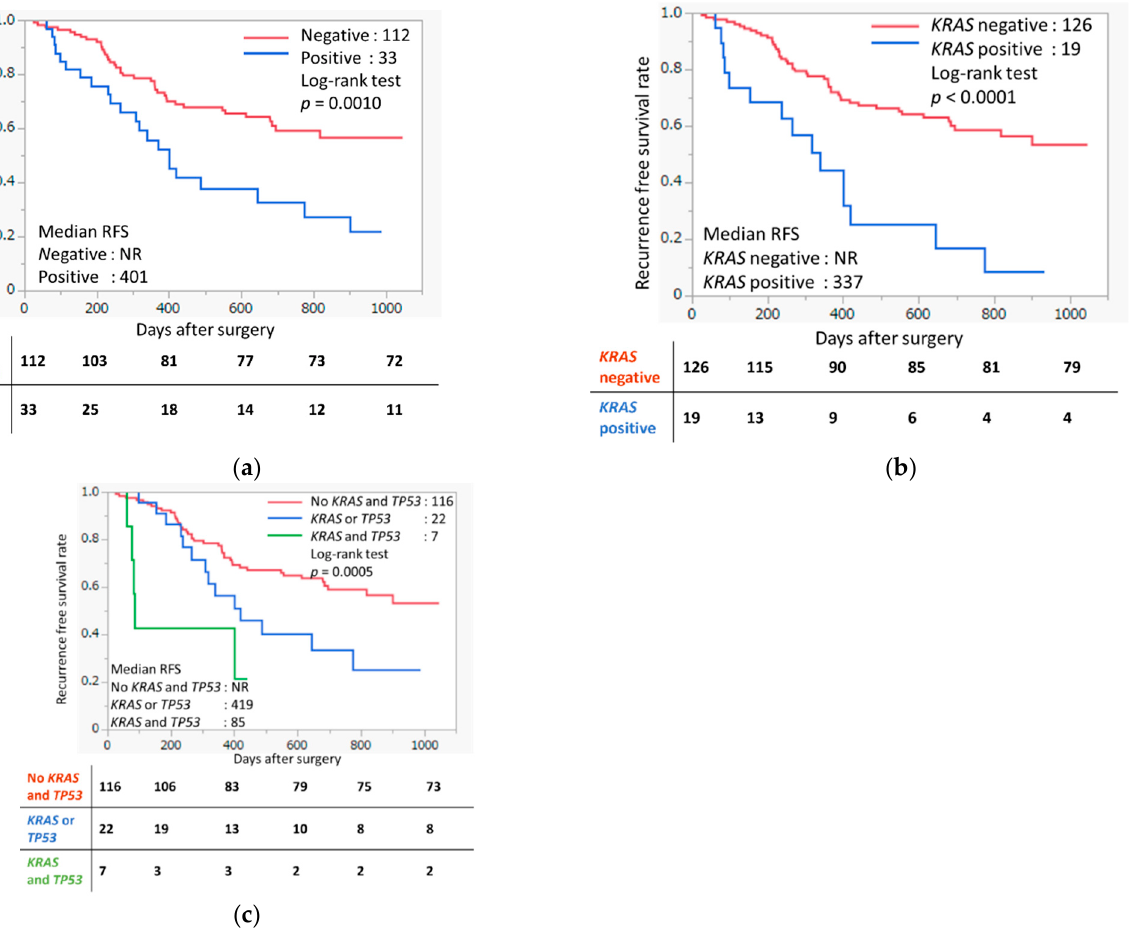
Figure 4. Association between the ctDNA concordant with tumor and liquid biopsy using NGS and recurrence-free survival (RFS). The differences in RFS were analyzed by log-rank test. The numbers below represent the number of recurrence-free cases at each time point (0, 200, 400, 600, 800, 1000 days). ( a ) Association between the ctDNA concordant with plasma and tumor and RFS. ctDNA positive cases had significantly shorter RFS than negative cases ( p = 0.0010). ( b ) Association between KRAS detection using tumor-informed approach and RFS. Cases with detectable KRAS ctDNA from liquid biopsy using NGS had significantly shorter RFS ( p < 0.0001). ( c ) Association between KRAS and TP53 detection using tumor-informed approach and RFS. Cases with detectable KRAS and TP53 ctDNA from liquid biopsy using NGS had significantly shorter RFS ( p =